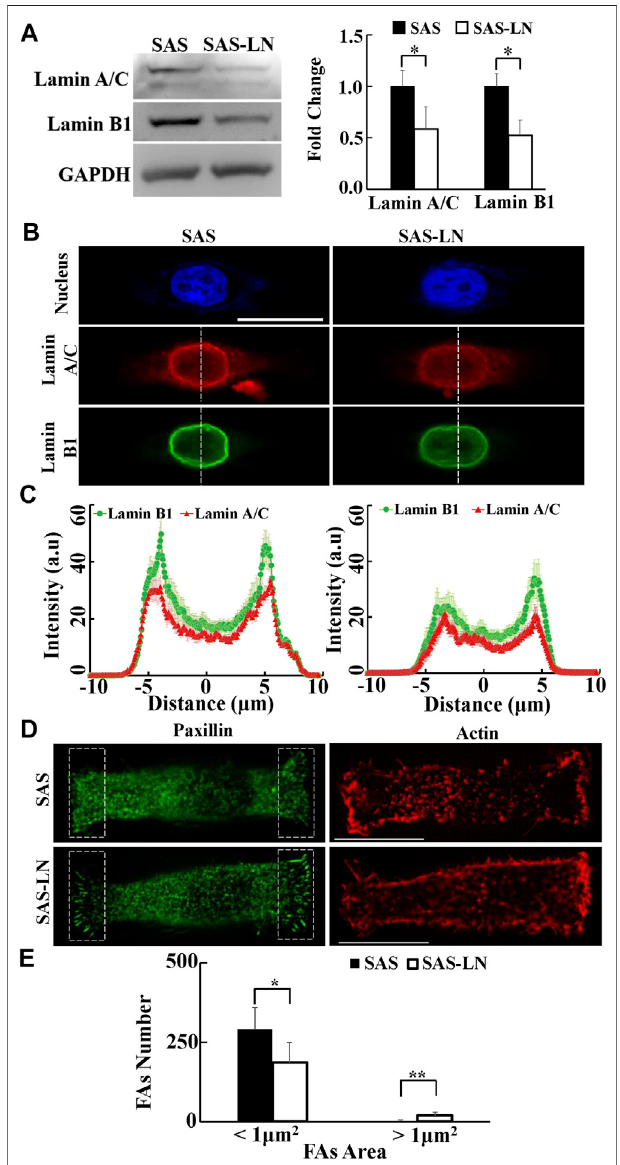
FIGURE 4 | Characterization of the nuclear biomolecules and focal adhesion size of LN-metastatic HNSCC cells (SAS-LN) and non-metastatic HNSCC cells (SAS). (A) Left: western blot of lamin A/C and B1 in SAS-LN and SAS cells. GAPDH was used as a loading control. Right: fold change expression of lamin A/C and B1 relative to SAS cells. Data represent mean ± SD (n = 3). *, for p < 0.05 and **, for p < 0.01. (B) Representative immuno fl uorescence images of the cell nuclei, lamin A/C and B1 in SAS-LN and SAS cells. Scale bars=20 μ m. (C) Quantitative measurement of the distribution pro fi les of lamin A/C and B1, indicated by the fl uorescence intensity distributions, in SAS-LN and SAS cells, along the dotted lines across the cell nuclei as shown in (B) . Data represent mean ± SD (n = 20). (D) Immuno fl uorescencemicrographsoffocaladhesionproteinspaxillinandactin fi laments in SAS-LN and SAS cells. Scale bars=20 μ m. (E) A comparison of the numbers of focal adhesions (FAs), with FAs area > 1 μ m 2 vs. those with FAs area < 1 μ m 2 , in SAS-LN and SAS cells, in the regions (8 μ m × 20 μ m) bounded by the white dotted rectangles shown in (D) . All data are expressed as mean ± SD from 15